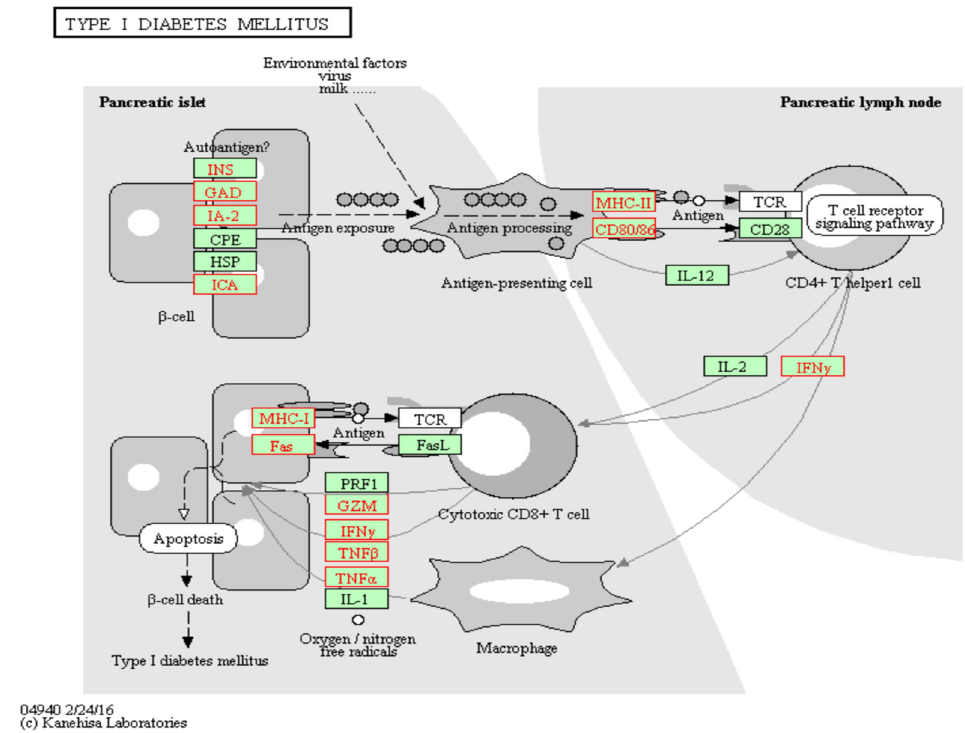
Figure 3. Cis e-QTL genes with trans-meQTL effects on cg19693031 identified in type 1 diabetes pathology. Cis e-QTL genes with meQTL effects on cg19693031 methylation are highlighted in red ( n = 23).